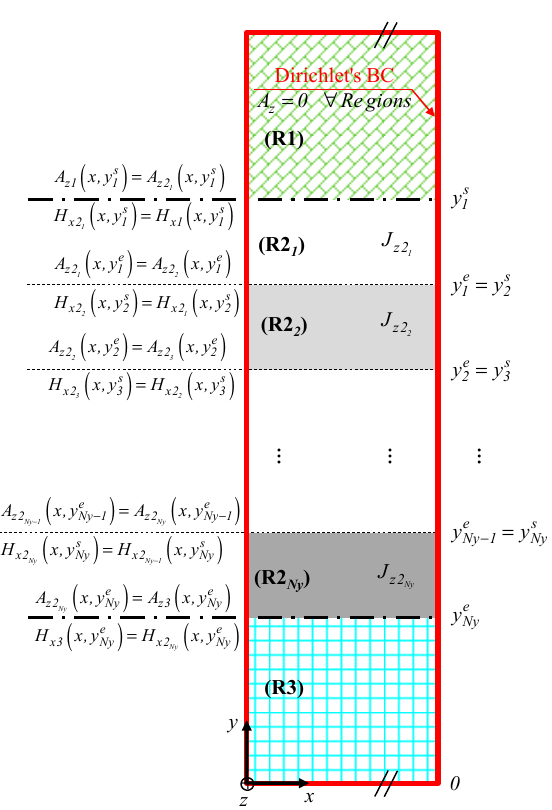
Figure 5. Boundary conditions at interface between (R1), (R2 i ) and (R3).